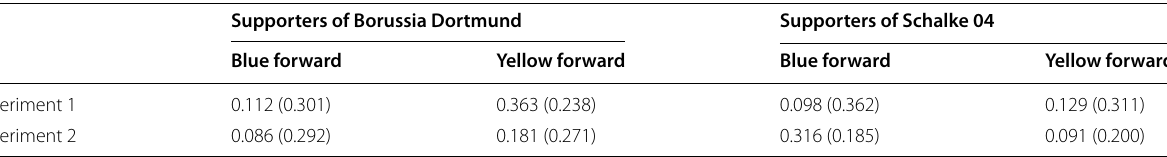
Table 3 Response bias index c as observed in Experiments 1 and 2 as a function of group (supporters of Borussia Dortmund vs. Supporters of Schalke 04) and attacking team (blue vs. yellow)